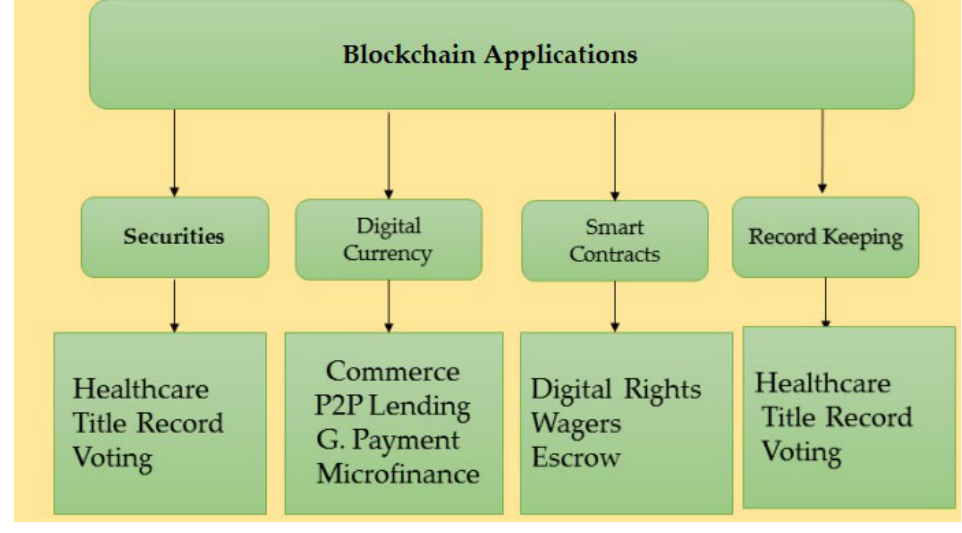
Figure 11. The blockchain Applications.